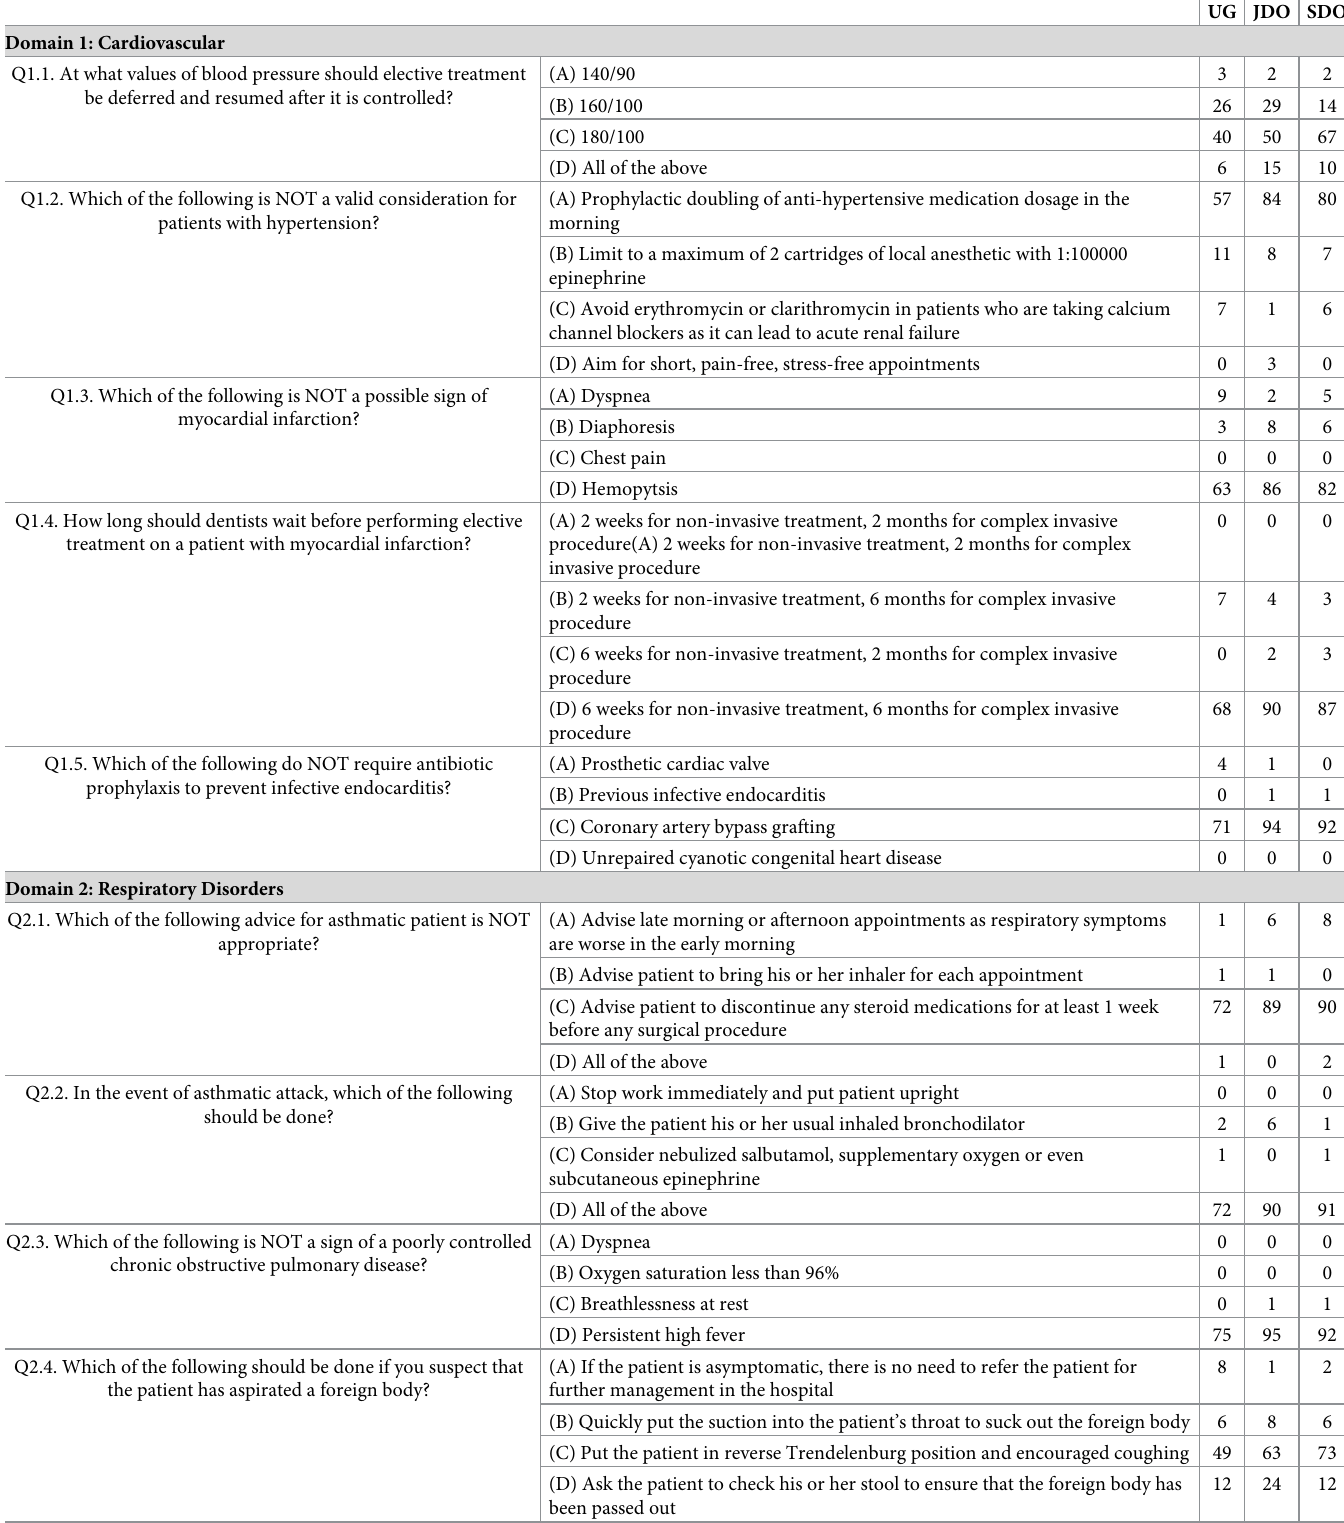
Table 2. Questionnaire on the six domains and respondents’